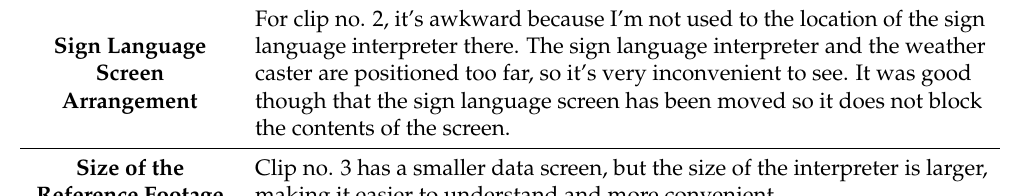
Table 8. Subjects’ opinions on the weather report